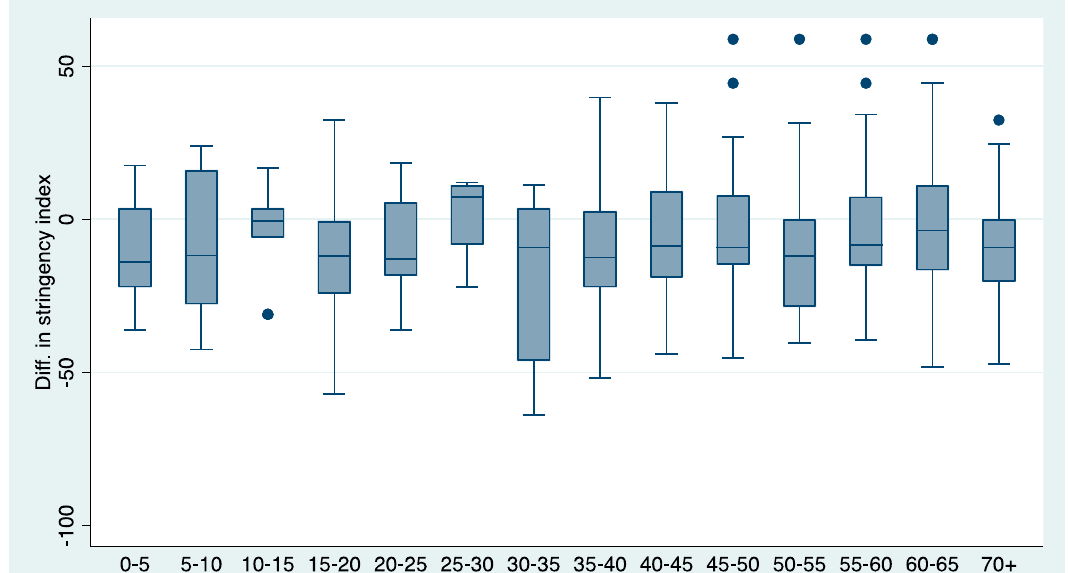
Figure 8. Median, interquartile range and variation in differences in stringency measures between the same period in 2021 and 2020, by vaccination coverage, all countries. Notes: Vaccination rate bins on the horizontal axis. Underlying data are calculated as differences in 7-day average of stringency index between the same week in 2021 and 2020. Median, interquartile range and variation are shown for the last available 6-week period (3 October to 14 November 2021 v. 4 October to 15 November 2020). Source: Our World in Data; own calculations.